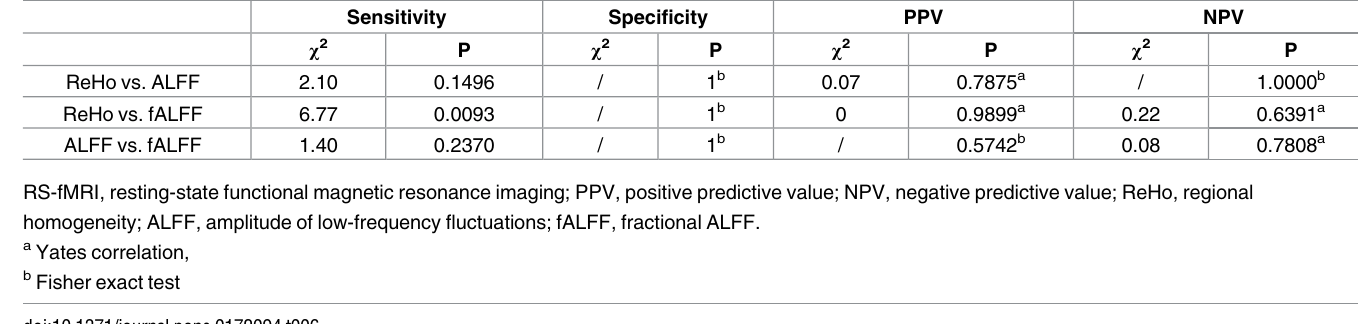
Table 6. Comparison of the three RS-fMRI